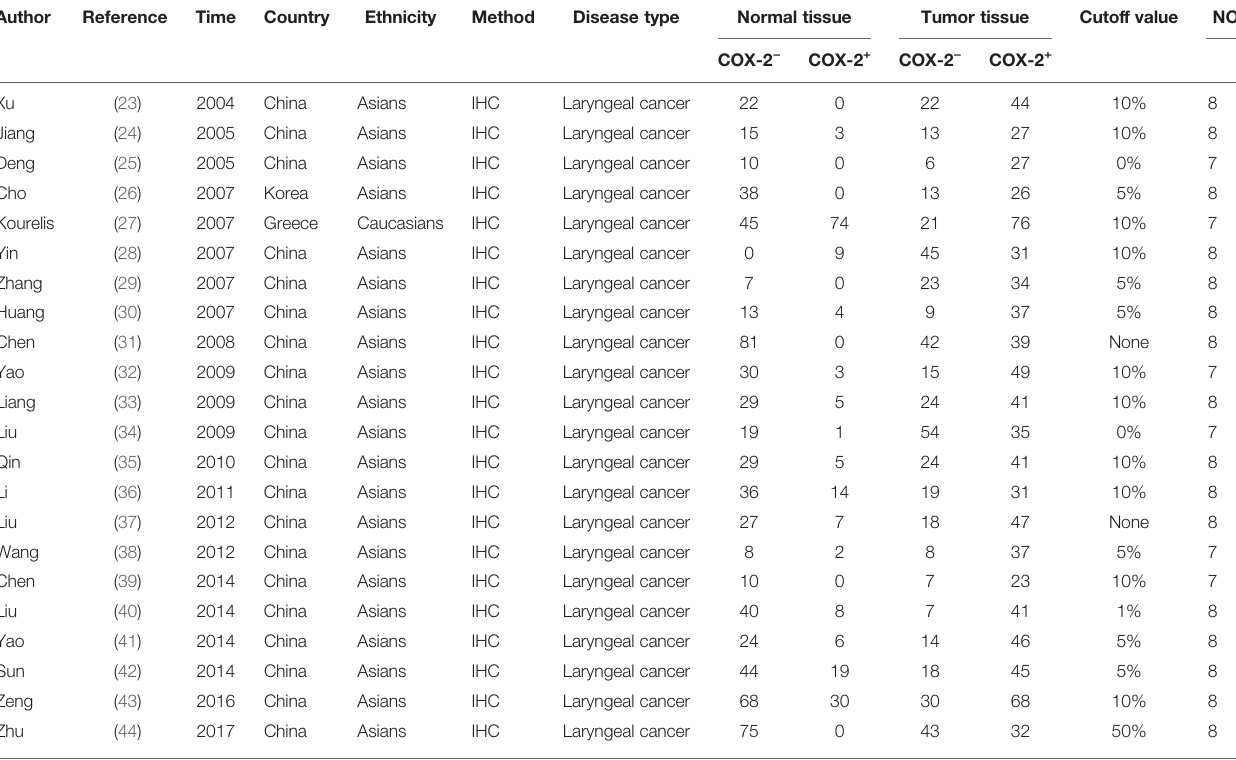
TABLE 1 | Characteristics of the included studies for risk of laryngeal cancer